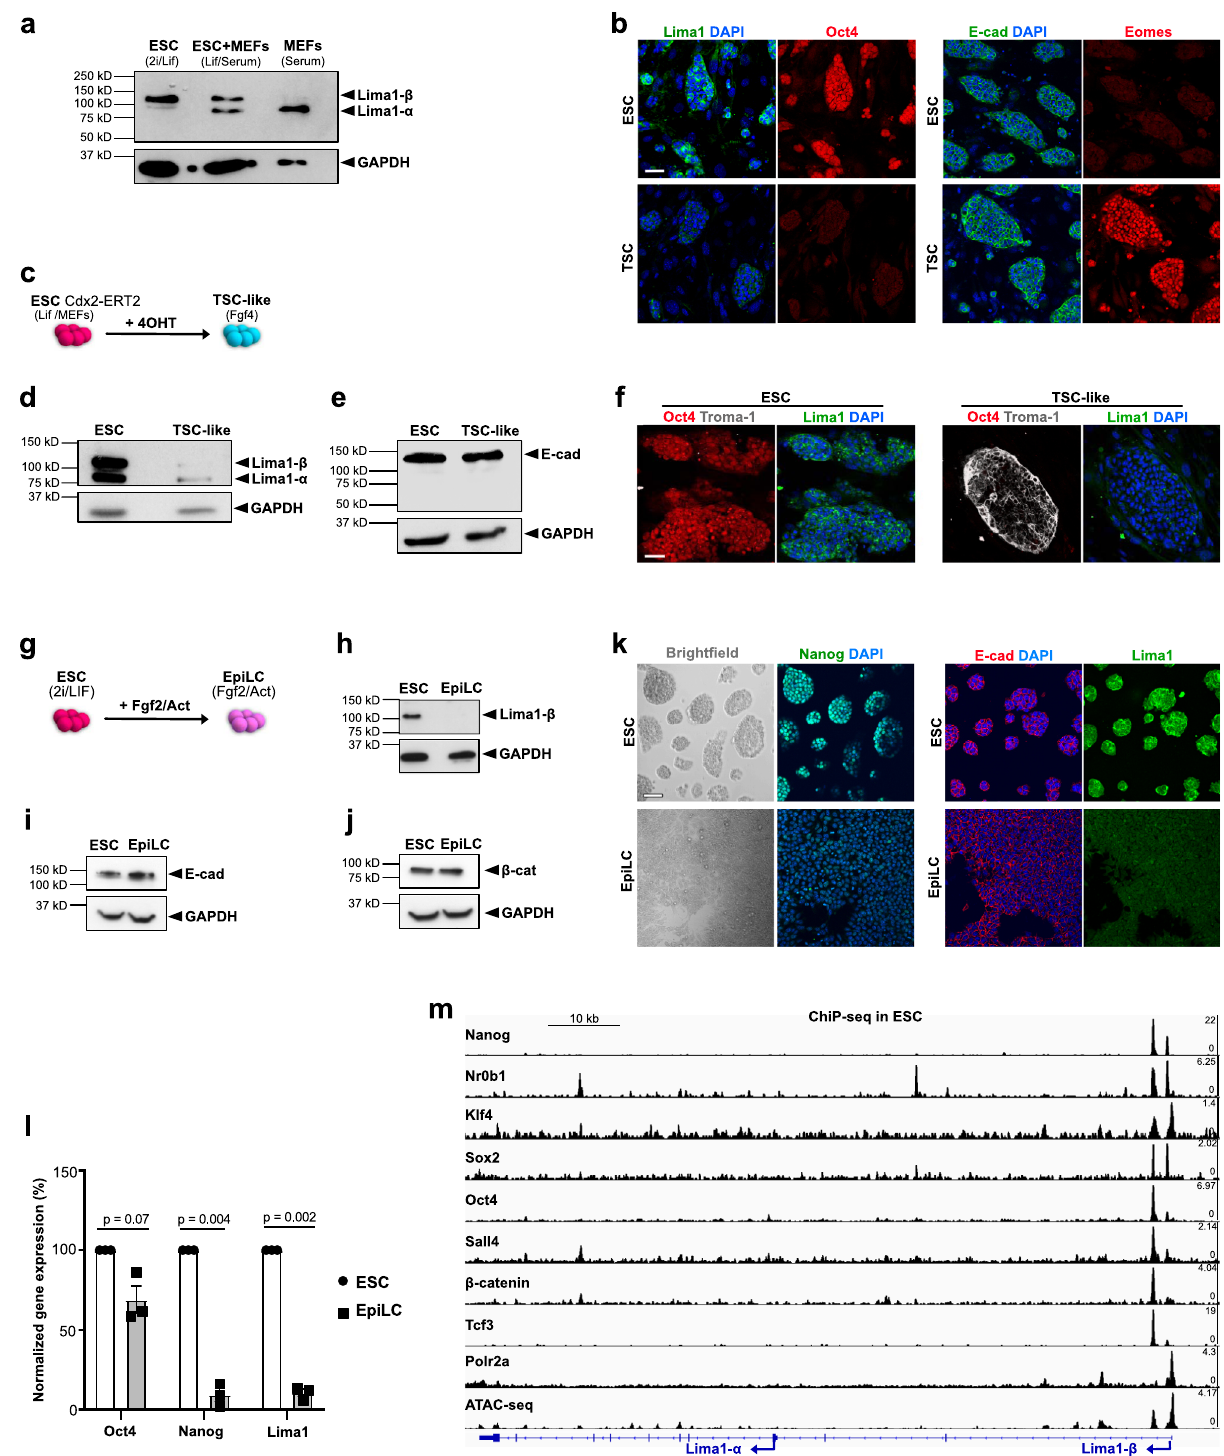
Fig. 2 Lima1 expression in embryonic and extraembryonic stem cell lines. a Western blot analysis of Lima1 expression in ESC and MEFs. b ESC and TSC stained for Lima1 and Oct4 (left panel) or E-cad and Eomes (right panel). c Schematic representation of ESC conversion to TSC-like cells. d Western blot analysis of Lima1 expression in ESC and TSC-like cells. e Western blot analysis of E-cad expression in ESC and TSC-like cells. f ESC and TSC-like cells stained for Oct4, Troma1 and Lima1. g Schematic representation of ESC conversion to EpiLC. h Western blot analysis of Lima1 expression in ESC and EpiLC. i Western blot analysis of E-cad expression in ESC and EpiLC. j Western blot analysis of β -cat expression in ESC and EpiLC. k ESC and EpiLC stained for Nanog (left panel) or E-cad and Lima1 (right panel). l Relative expression levels of Oct4, Nanog and Lima1 normalized to GAPDH in ESC and EpiLC. Mean values from three independent repetitions, data represent mean ± SEM, unpaired Student ’ s t -tests, 2-sided. m ChIP-seq peaks of pluripotency factors binding on the Lima1 locus in ESC. Polr2a peaks indicate the promoter region, ATAC-seq peaks indicate the accessible chromatin regions. Scale bars, ( b ), ( f ), ( k ), 50 μ m. Experiments were repeated independently two times ( a, b, e, f, i, j, k ) or three times ( d, h ) with similar results. Related to Figure S2.